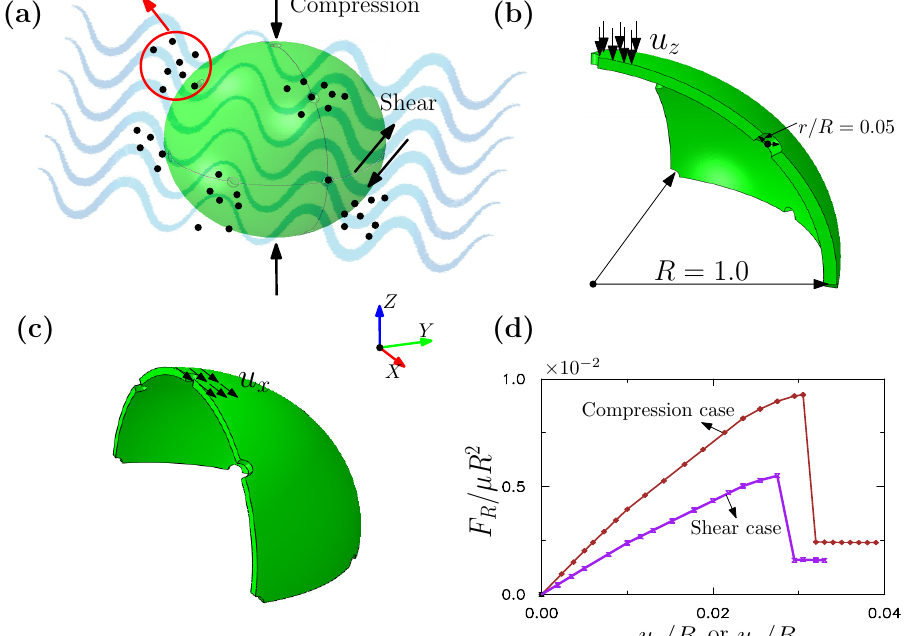
Figure 8. Fracture of a spherical shell subjected to compression and shear. ( a ) Spherical shell model for drug delivery. ( b ) One eighth spherical shell model. ( c ) A quarter spherical shell model. Geometric dimensions and boundary conditions of the model are given. ( d ) The reaction force vs. displacement